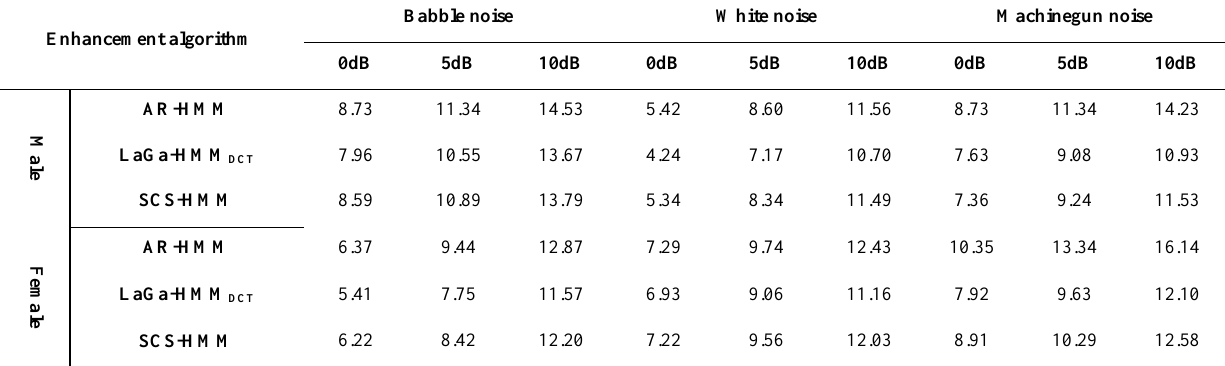
Table 1. Comparative performance in terms of SNR.